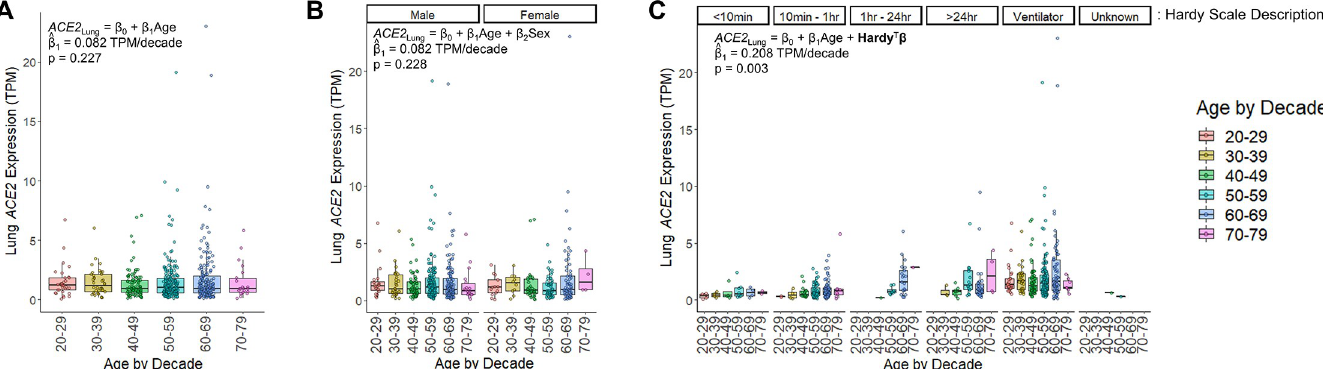
Fig 1. ACE2 RNA expression increases with age and mechanical ventilation in the lung. A) Human lung ACE2 expression is colored by decade of life when the individual died. In unadjusted linear regression, there was no significant effect of age on ACE2 expression (p = 0.227, n = 578 individuals). B) ACE2 expression in lung stratified by sex. Analysis adjusted for age and sex, revealed no significant effect for either variable (p = 0.228 for age, p = 0.920 for sex, multivariate regression, n = 395 males, n = 183 females). There was also no significant difference when compared by sex alone (p = 0.303, Wilcoxon rank-sum test). C) ACE2 expression in lung stratified by the Hardy scale. This scale indicates the length of time spent in the terminal phase before death, which is depicted above each grouping of data points. Within each Hardy scale group, the data are sub-stratified by age. (n = 26 for a score of 1 representing a violent and fast death lasting < 10 minutes, n = 156 for a score of 2 representing a fast death by natural causes lasting 10 minutes– 1 hour, n = 31 for a score of 3 representing an intermediate rate of death lasting 1 hour– 24 hours, n = 64 for a score of 4 representing a slow death with a terminal phase lasting > 24 hours, n = 299 for a score of 0 representing donors supported by a ventilator preceding death, n = 2 with an unknown score). For all panels, each point represents a sample from a unique individual. Box plots indicate quartiles. A linear model fit to the data is inset, indicating the estimated coefficient for age ( β 1 ) and its